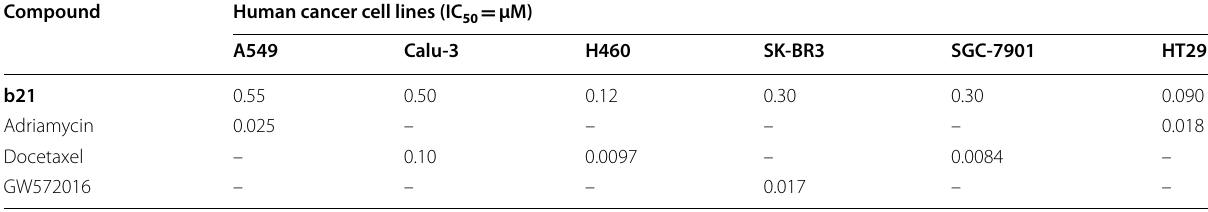
Table 23 In vitro anticancer activity of compound b21 Compound